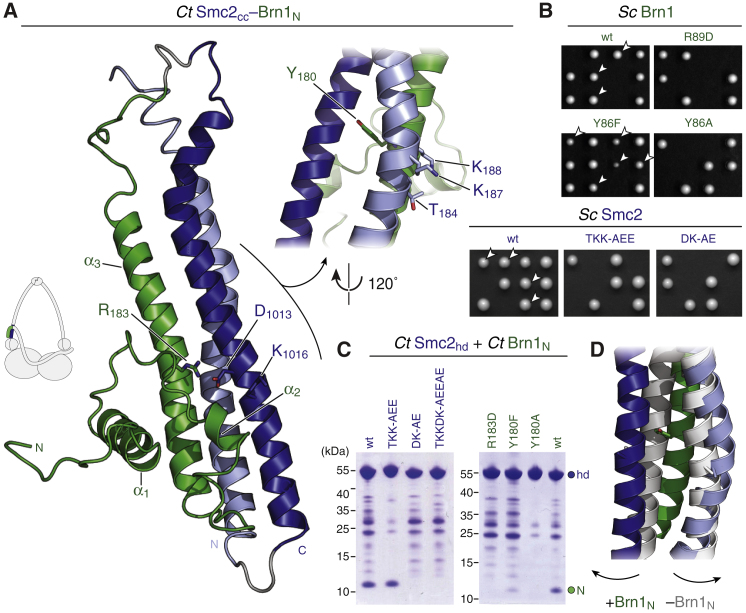
Structure of the Smc2cc-Brn1N Interface(A) Cartoon model of the lowest-energy Ct Smc2cc-Brn1N NMR structure. Residues chosen for mutational analysis are highlighted. The close-up view shows Ct Brn1Y180 intercalating into the Smc2 coiled coils and the positions of additional residues chosen for mutagenesis.(B) Diploid Sc BRN1/brn1Δ strains expressing an ectopic PK6-tagged copy of WT Brn1 (strain C5239) or Brn1R89D (C5263), Brn1Y86F (C5262) or Brn1Y86A (C5261) mutant versions and diploid Sc SMC2/smc2Δ strains expressing an ectopic PK6-tagged copy of WT Smc2 (C5277), Smc2TKK-AEE (C5278), or Smc2DK-AE (C5279) mutant versions were dissected and incubated for 3 days at 30°C.(C) Co-elution of His6-tagged WT or mutant Ct Smc2hd constructs (left) and untagged WT or mutant Ct Brn1N constructs (right) from Ni-Sepharose beads tested by SDS-PAGE and Coomassie staining of elution fractions.(D) Comparison of Smc2cc conformations in the Ct Smc2cc-Brn1N NMR and Ct Smc2hd crystal structures. Cβ atoms of Smc2A186 and Smc2H1015, shown as sticks, serve as rotational markers.See also Figure S7.